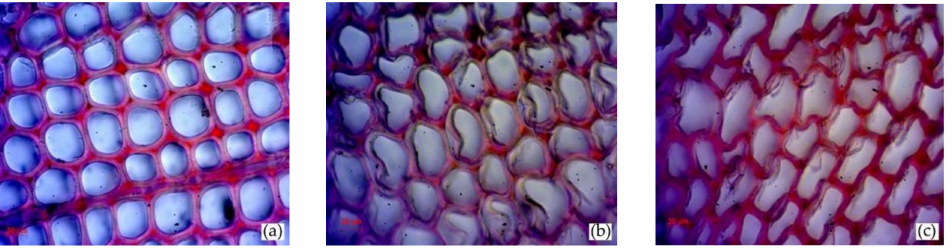
Figure 1. The changes of tracheid cell, ( a ) control, ( b ) radial surface, and ( c ) tangential surface, under high magnification ( × 40).